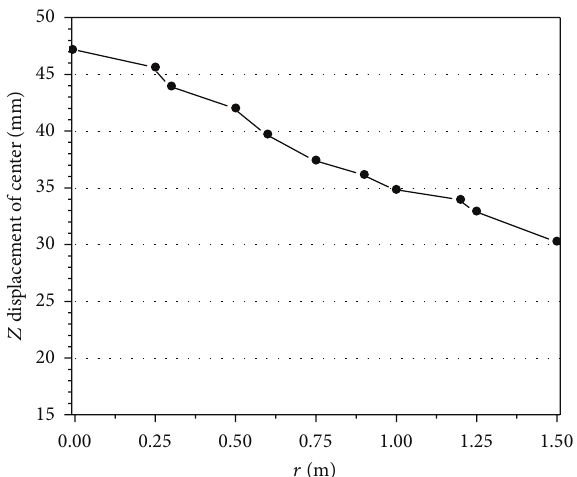
Figure 9: Maximum displacement of slab center under different explosive positions.